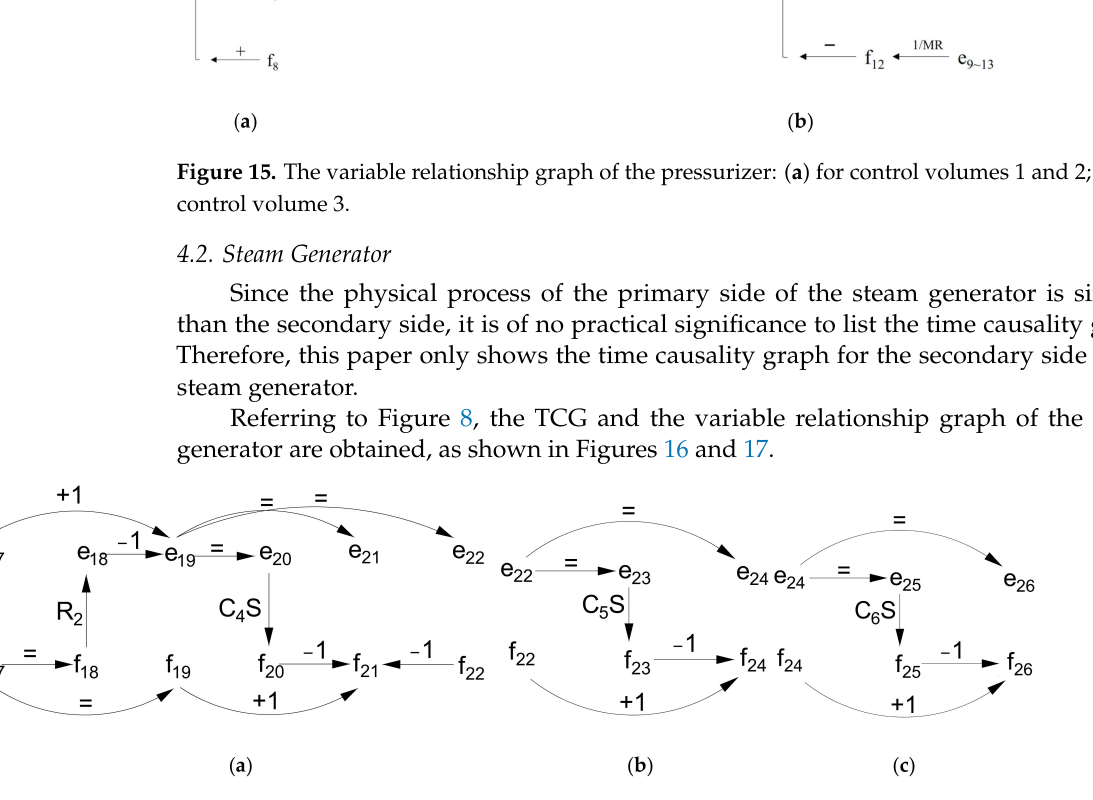
Figure 16. TCG of the steam generator: ( a ) for control volume V W ; ( b ) for control volume Vs; ( c ) for control volume V D .